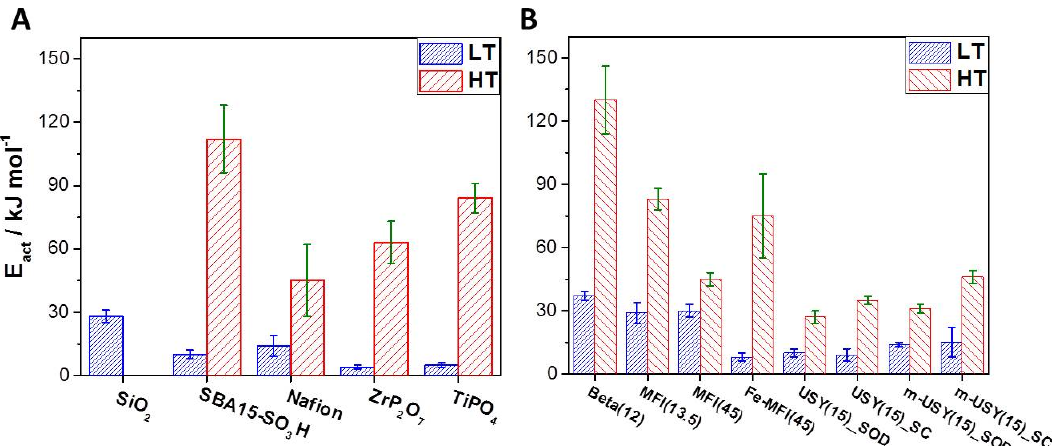
Figure 4. Apparent activation energies for proton transfer with experimental errors plotted for different materials. Values for low-temperature ranges are in blue (348–423 K), and values for elevated temperatures (423–523 K) are in red. ( A ) Data for classical proton-conducting materials and ( B ) data for different zeolites. Several silicon rich zeolites exhibit similar or even lower activation energies for proton transfer as TMPs which are commonly used for high-temperature PEM fuel cells.